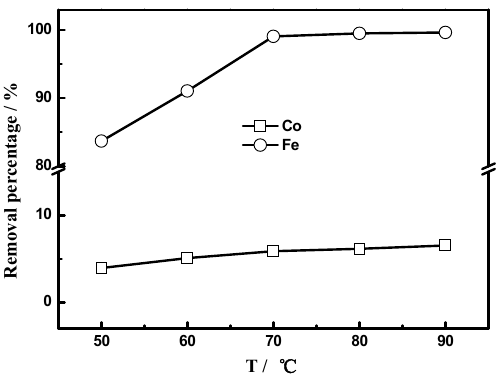
Figure 7. Effect of temperature on the removal rate of iron and cobalt (soaking time = 1 h, equilibrium pH = 3.5).